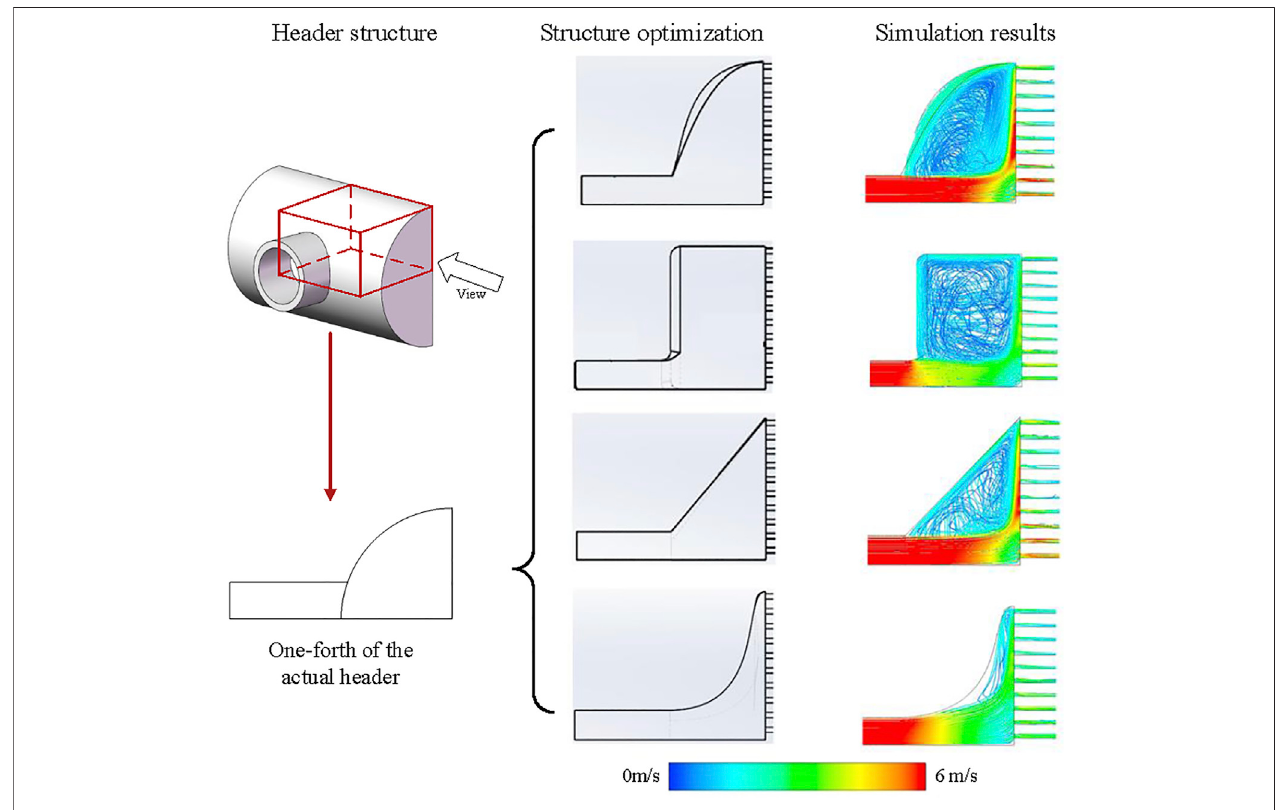
FIGURE 12 | Schematic diagram of inlet header optimization (Chu et al.,